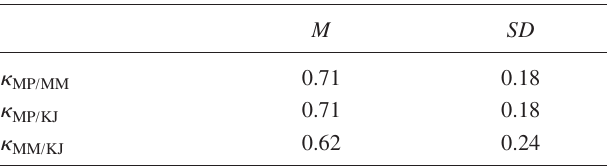
TABLE VIII. Relative frequency of correctly phrased proposi- tions for control group (cid:1) N =287 (cid:2) and treatment group (cid:1) N =287 (cid:2) .